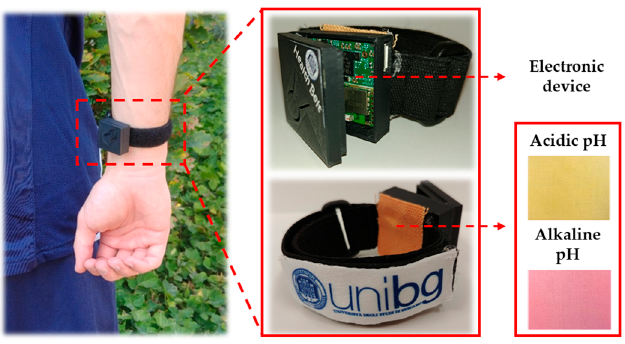
Figure 4. Prototype “Health Belt” for the real-time monitoring of sweat pH.